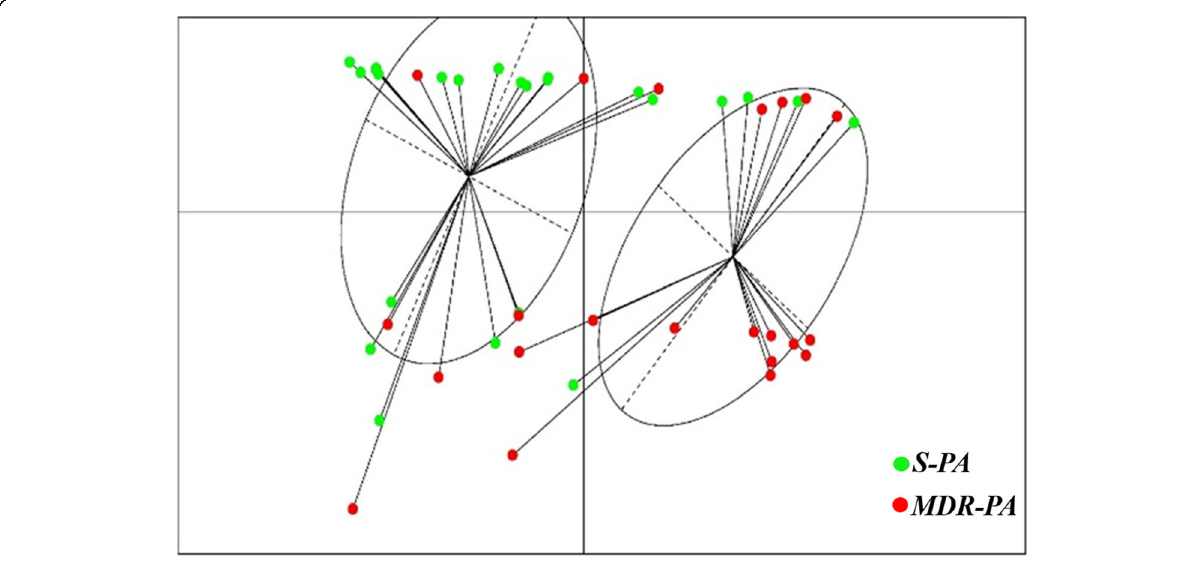
Fig. 5 Principal coordinate analysis (PCoA) plot of S-PA (left) and MDR-PA (right) and the high-resolution display of red square indicates MDR-PA isolates while the green dot represents S-PA isolates. PCoA plot was generated from the values obtained from Pyoverdine, biofilm, protease and motility test ( n = 23 in each